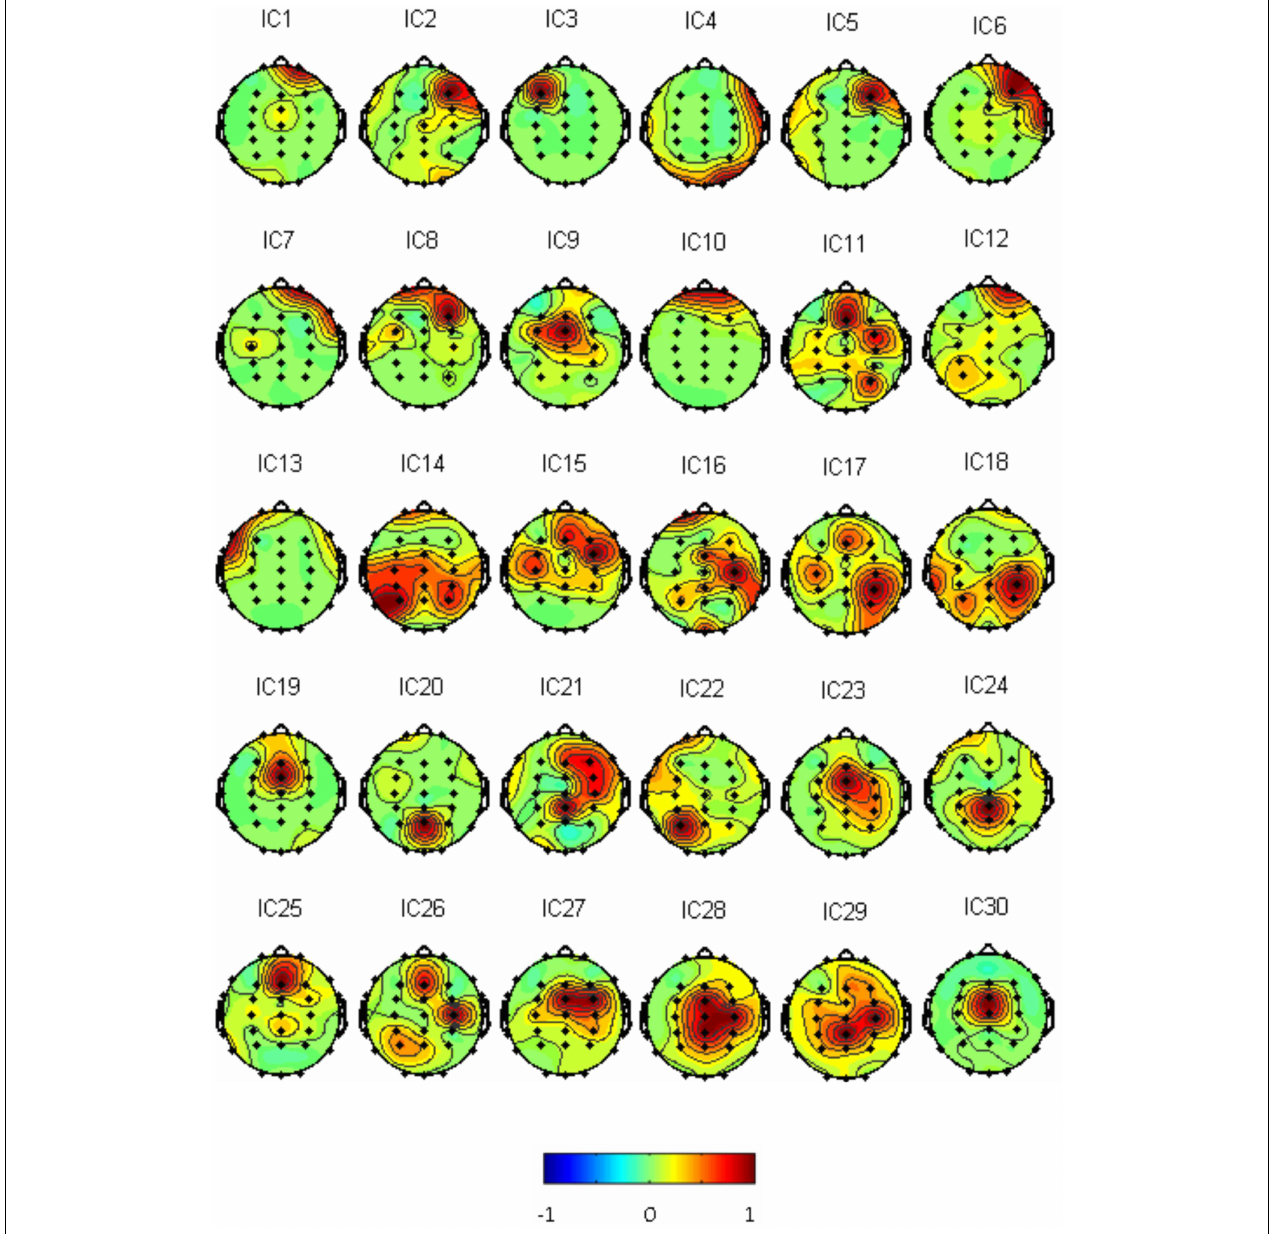
FIGURE 5 | Thirty Fourier ICA spatial distributions of the subject S3 (blue represents –1, red represents